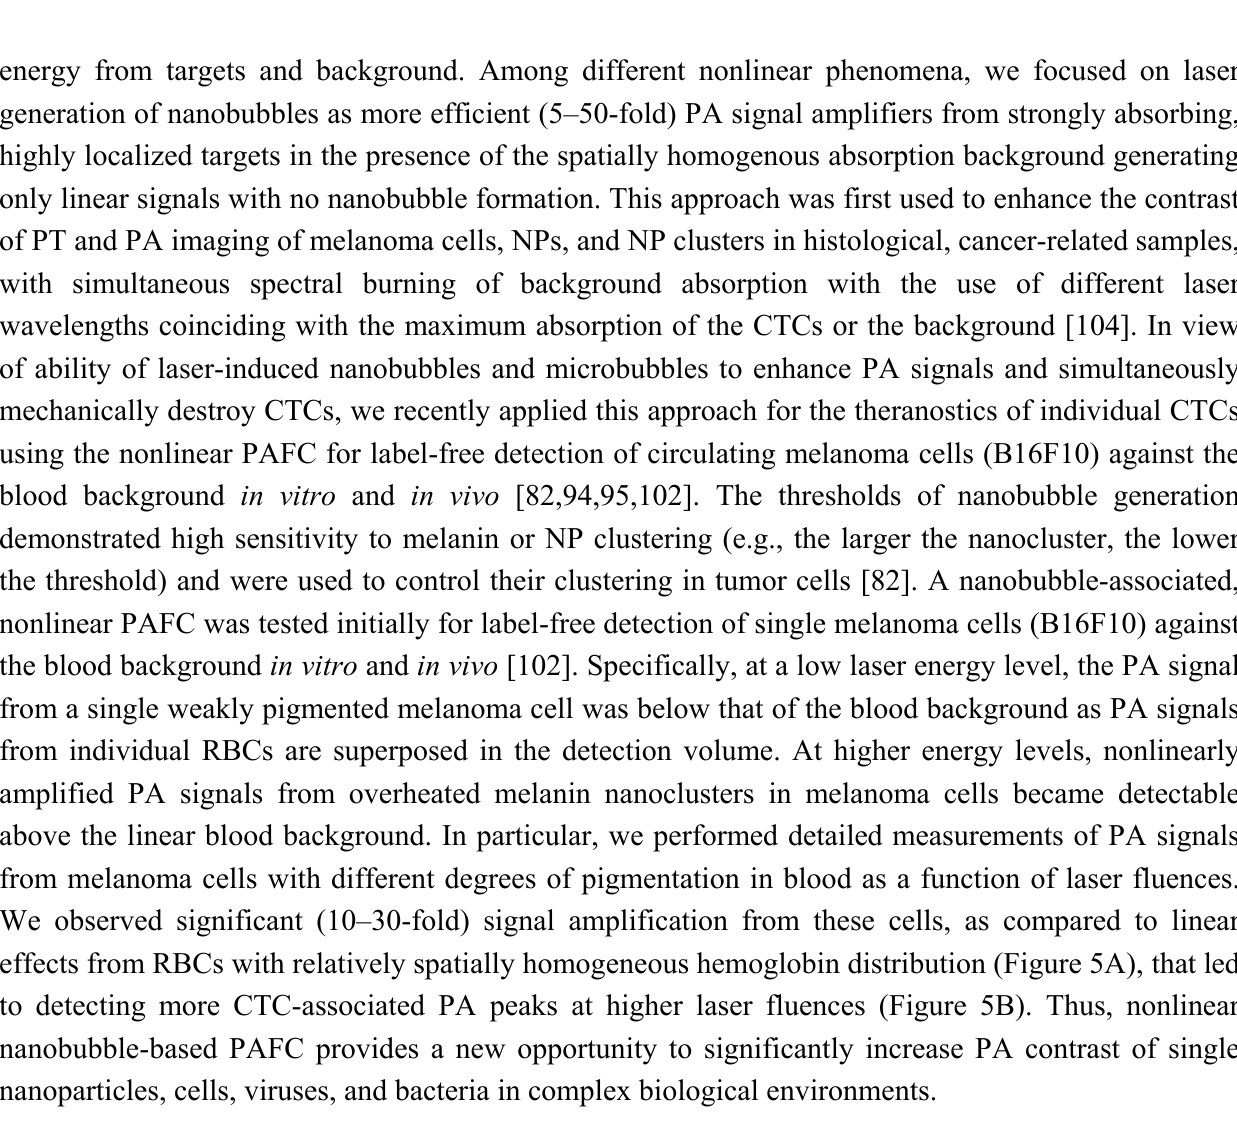
Figure 5. Nonlinear PA signal amplification at 820 nm in melanoma cells (B16F10) with different pigmentation under static ( A ) and flow ( B ) conditions as a function of the laser energy fluences